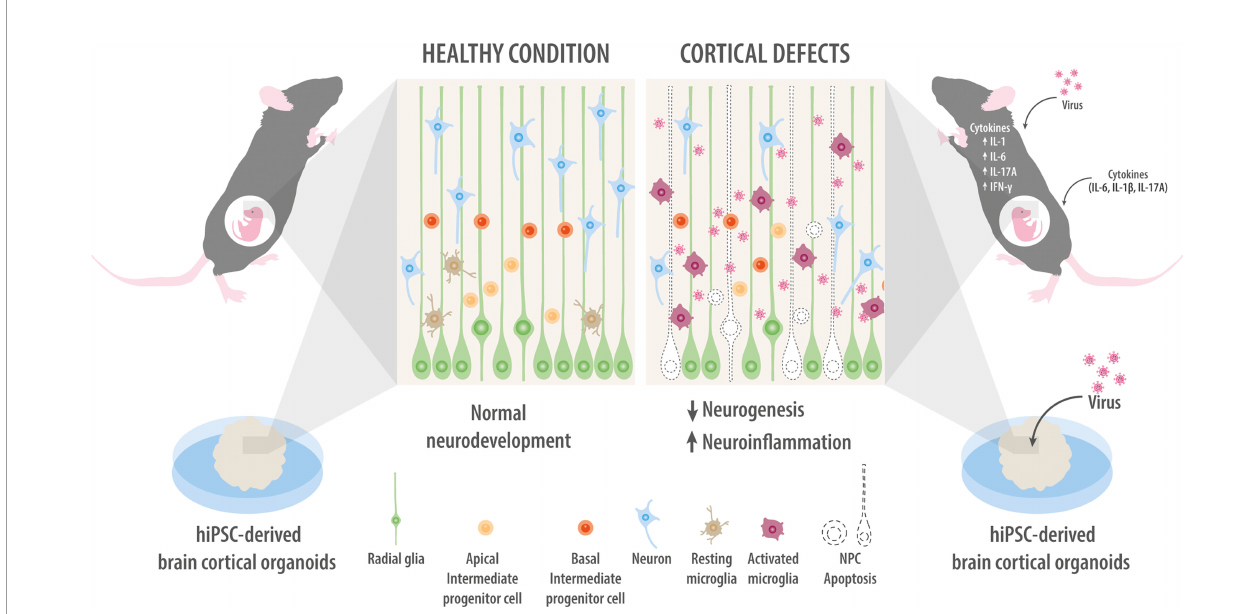
FIGURE 2 | Models of maternal infection. Modeling of maternal infection in mice either by injection of viruses or cytokines (upper right panel). Maternal infection activates microglia and neuroin fl ammation while inhibiting NPC proliferation and neuronal migration. Infecting brain organoids with Zika virus or Cytomegalovirus inhibits NPC proliferation and promotes their apoptosis, ultimately shrinking the organoid (bottom right panel). For comparison, mock-infected NPCs are intact and show normal organization of the different cortical layers, as well as normal levels of neuronal migration and survival (left